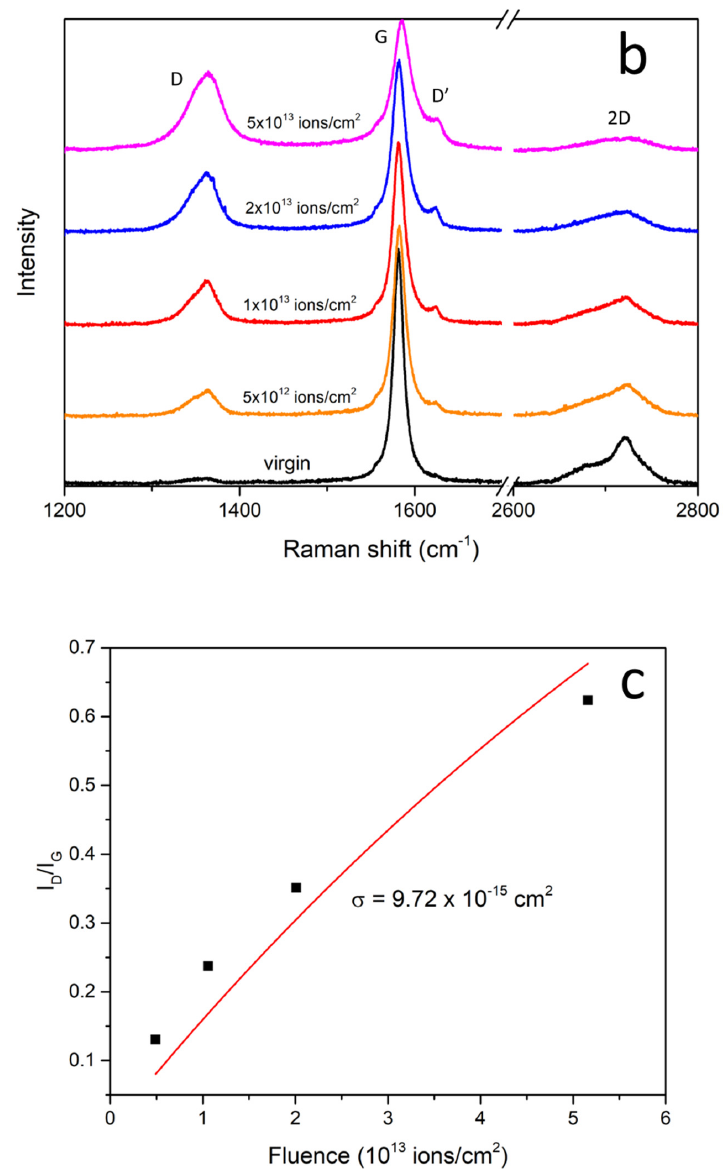
Figure 3. ( a ) RBS/c spectra from HOPG irradiated at normal incidence with 23 MeV I to 5 × 10 13 ions/cm 2 . ( b ) Raman spectra from HOPG irradiated with 23 MeV I to different fluences up to 5 × 10 13 ions/cm 2 . ( c ) Damage kinetics in HOPG obtained from Raman spectroscopy data and presented as an increase of I D /I G ratio.